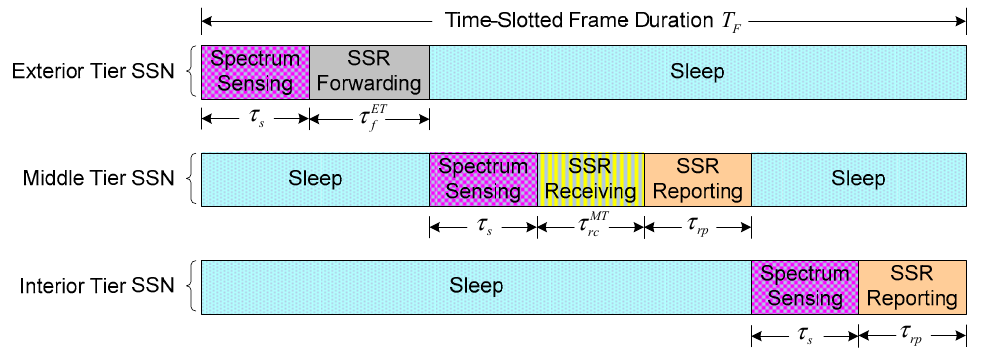
Figure 2. The time-slotted frame structure adopted by dedicated spectrum sensor nodes (SSNs) in time-slot duration T F . SSR: spectrum sensing